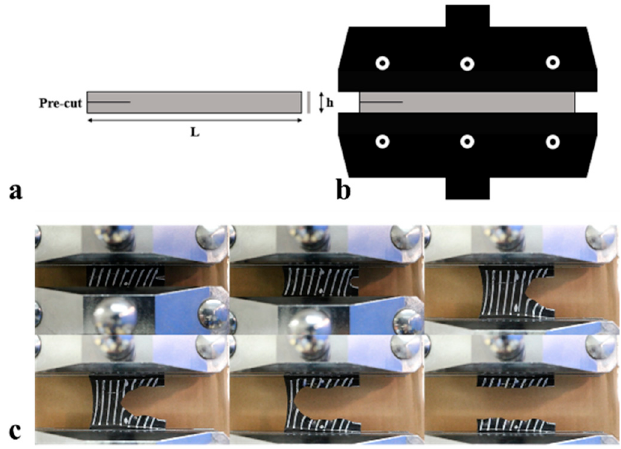
Figure 2. ( a ) Planar tension test specimen (length 100 mm, width 10 mm, thickness 1 mm, pre-cut 15 15 mm), ( b ) specimen fixture ( c ), shape and location of crack tip at di ff erent loading mm), ( b ) specimen fixture ( c ), s hape and location of crack tip at different loading displacements.